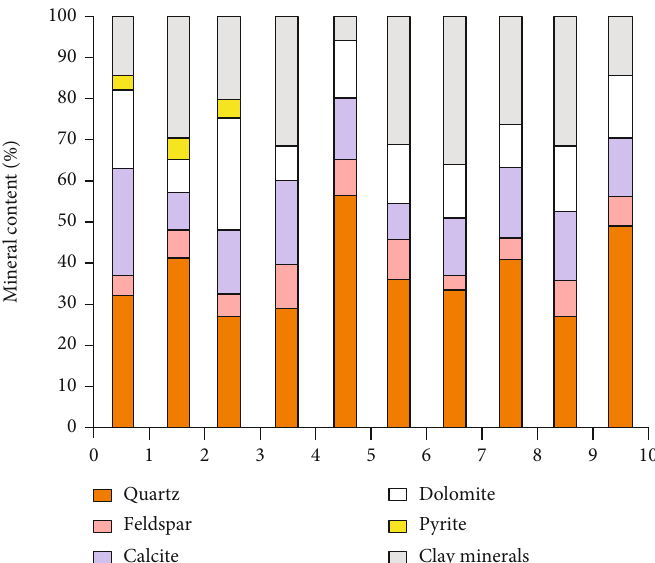
Figure 2: Mineral composition of the shale reservoir in the Longmaxi